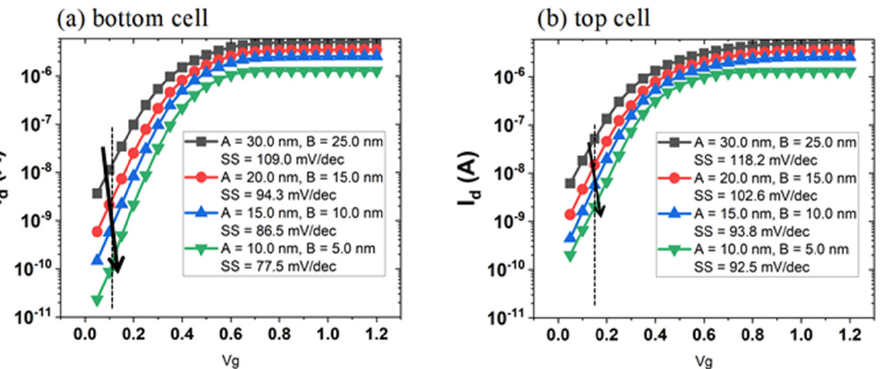
Figure 7. Simulated I d vs. V g . with xy-scaling, the subthreshold swing (SS) improves in both ( a ) bottom cell and ( b ) top cell. When the form of the channel near or at the bottom cell looks like a nanowire structure (i.e., A = 10.0 nm, B = 5.0 nm), SS becomes 77.5 mV/dec at 300 K. Depending on the physical dimension of the channel radius, the threshold voltage of each bit cell in a string is different from that of the others (see Figure 8): (i) for the range of (A, B) = (20.0 nm, 15.0 nm)~(56.5 nm, 51.5 nm), the bottom cell in the vertical string has a lower threshold voltage than the top cell. (ii) For the range of (A, B) = (12.5 nm, 7.5 nm) ~(15.0 nm, 10.0 nm), the threshold voltage of top and bottom cell becomes comparable. (iii) For the range of (A, B) = (9.0 nm, 4.0 nm)~(10.5 nm, 5.5 nm) (herein, the bottom cell has a nanowire structure), the bottom cell has a higher threshold voltage than the top